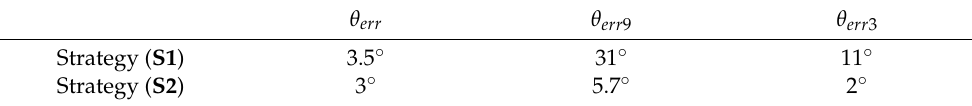
Table 5. Resulting position error (electrical angle) from strategies ( S1 ) and ( S2 ).